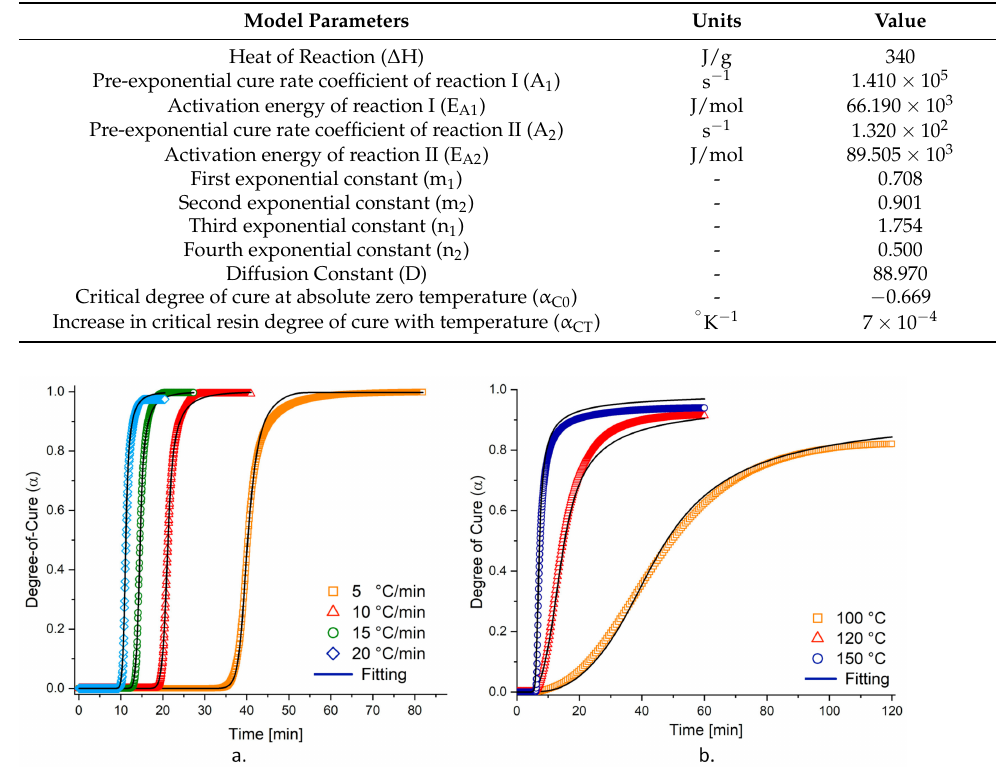
Figure 3. Degree of cure profiles of ( a ) dynamic heating rates and ( b ) isothermal temperature profiles. The experimental data (symbols) is compared with the model predictions (continuous lines) (For an interpretation of the references to the colors in this figure’s legend, the reader is referred to the web version of this